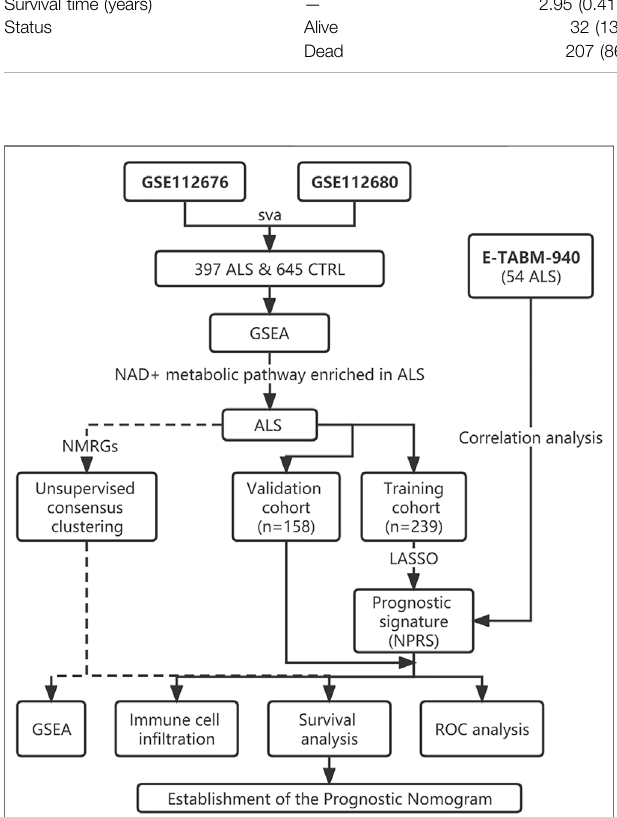
FIGURE 1 | Flow chart of the study design. ALS, Amyotrophic Lateral Sclerosis; CTRL, Control; GSEA, Gene set enrichment analysis; NMRGs, NAD+ metabolism-related genes; NPRS, NAD+ metabolism-related prognostic risk score; ROC, Receptor operating characteristic.